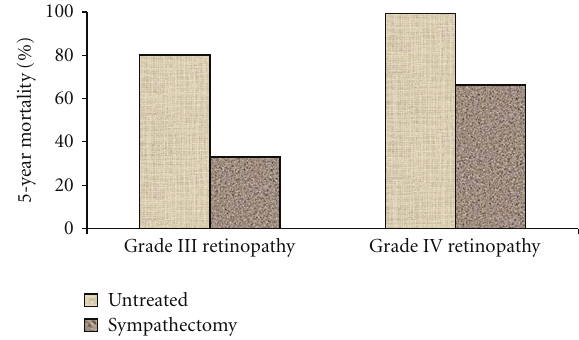
Figure 1: Five-year mortality rates (%) in untreated patients with malignant hypertension and Grade III or IV retinopathy compared to similar patients that underwent sympathectomy (modified from Keith et al. [25] and Peet et al.